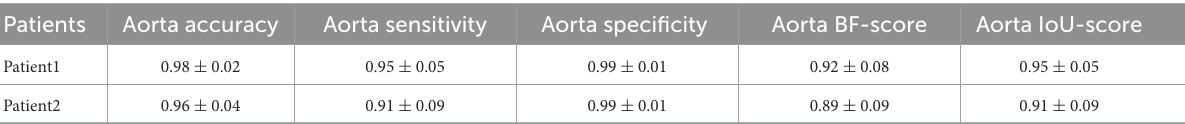
TABLE 4 Measured accuracy, sensitivity, specificity, BF-score, and IoU-score for the detection of the aorta in CT images of the two challenging cases.